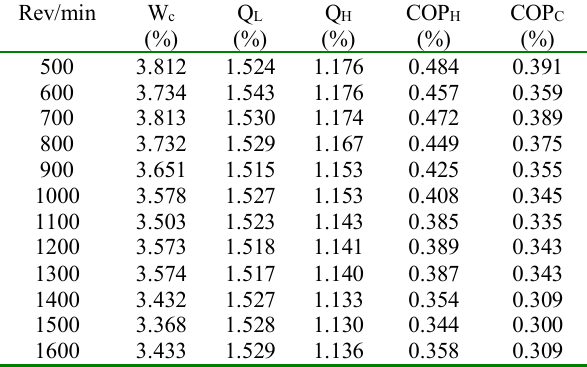
Table 1. Uncertainties for each compressor